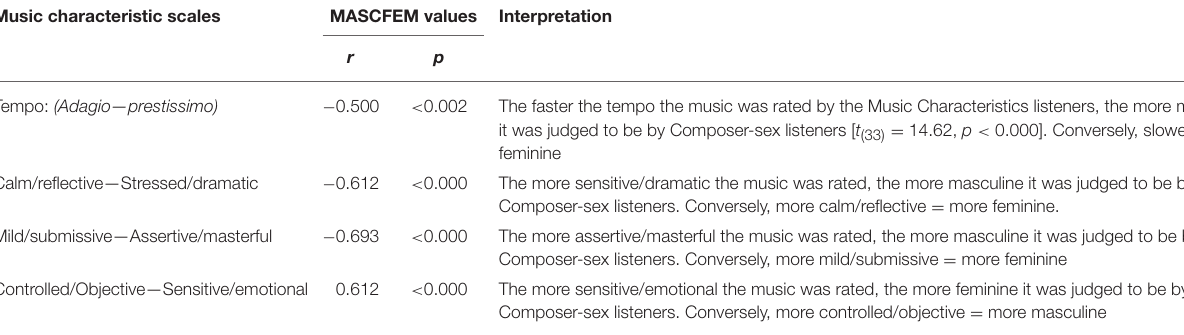
TABLE 3 | Correlations of MASCFEM values with music characteristics